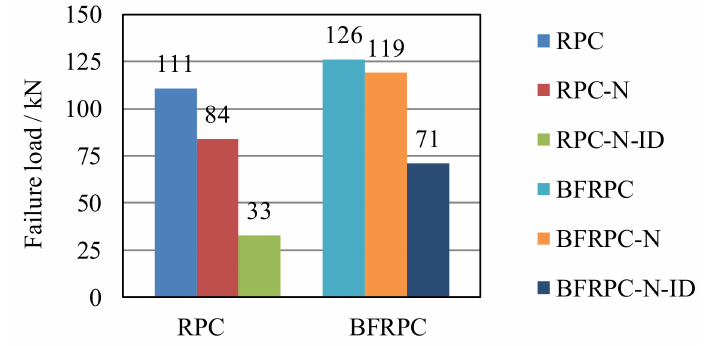
Figure 9. Maximum bearing